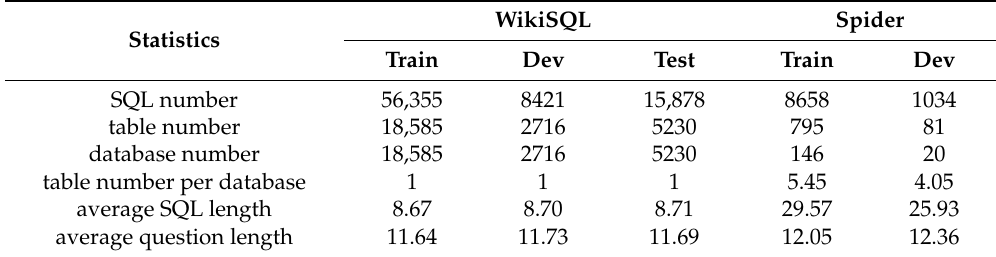
Table 3. Statistics for WikiSQL and Spider.